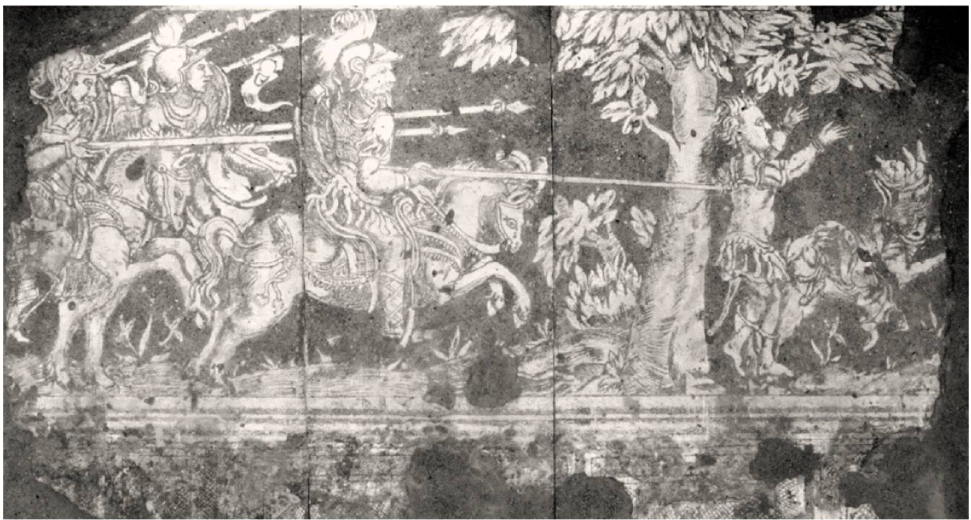
Figure 36. A fragment of the sgraffito decoration of the manor house in Zagrodno (now the Regional Museum in Chojnik) with the scene of the Battle of the Amalekites. Photo J. Kos, 2001.